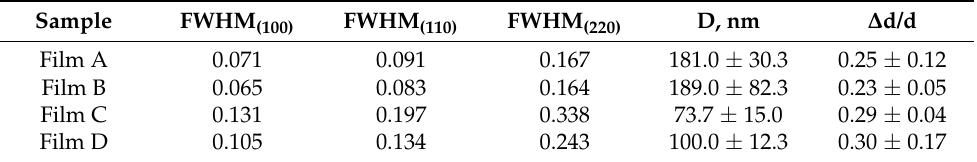
Table 1. The FWHM values of perovskite XRD peaks 100, 110, and 220, crystallite size D, and the value of microdeformation  d/d in different perovskite films.